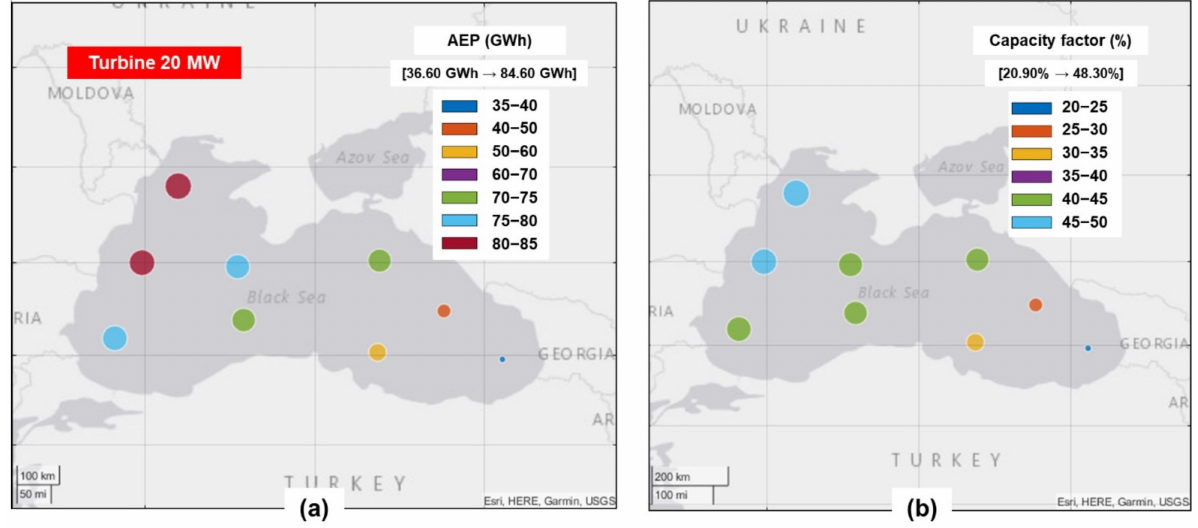
Figure 13. Performances of a theoretical wind turbine defined by a rated capacity of 20 MW, where: ( a ) annual electricity production; ( b ) capacity factor. These results are processed for a hub height of 160.2 m, according to the details mentioned in Ashuri, et al. [27]. The numbers from the square brackets indicate the minimum and maximum values related to each